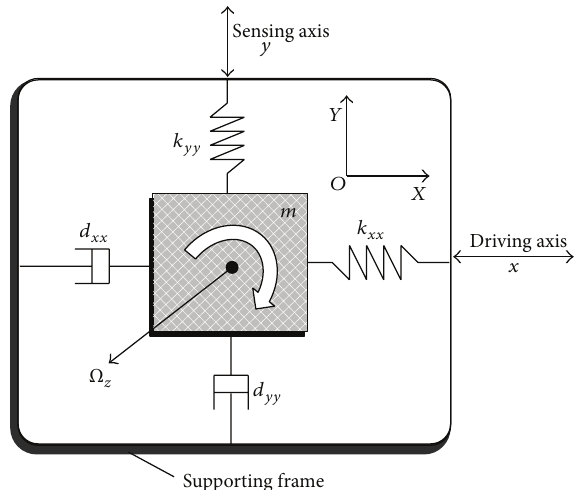
Figure 1: Schematic model of a two-axis MEMS vibratory gyro-